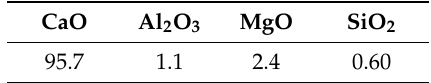
Table 4. The Lime chemical composition, in wt. %.